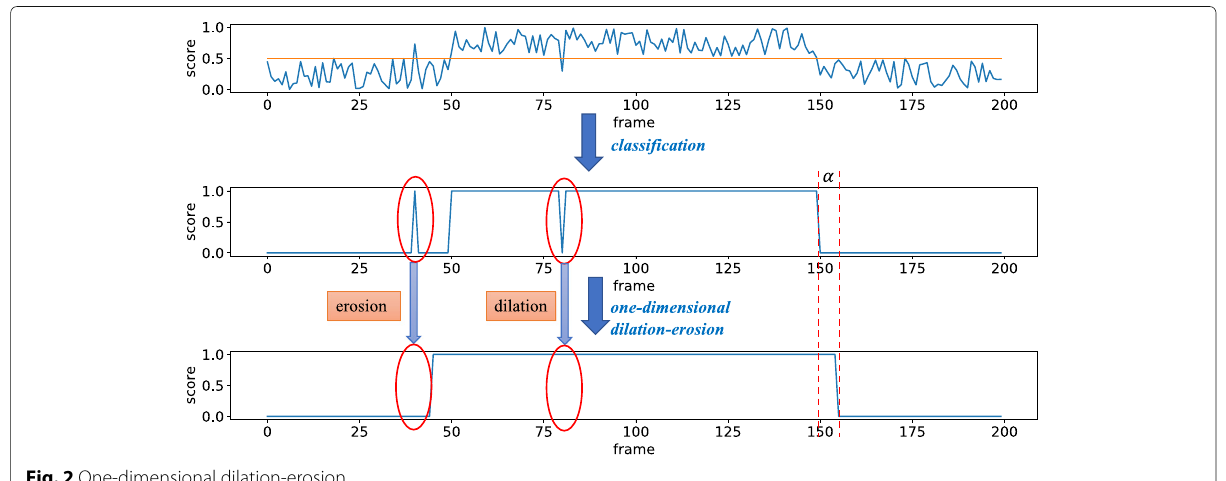
Fig. 2 One-dimensional dilation-erosion